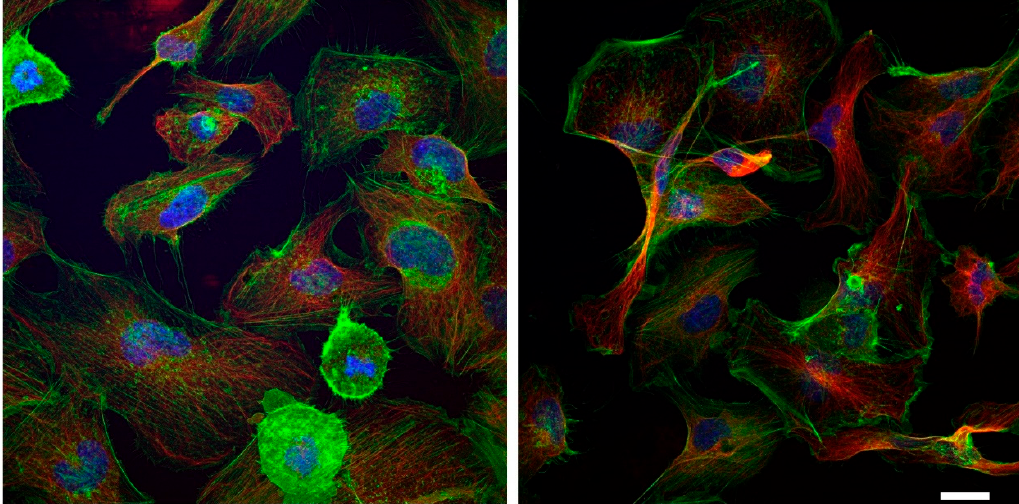
Figure 5. Effect of urea on microfilament and microtubule organization in HMEC-1. On the ( left ), control cells at 72 h. On the ( right ), cells treated with 5 g/L urea for 72 h. Green, microfilaments; red, microtubules; blue, DNA in the nucleus.